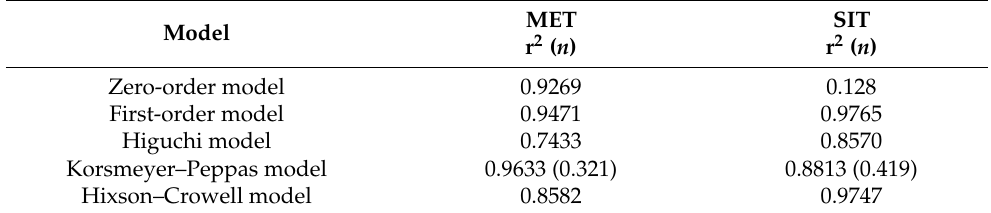
Table 4. In vitro release kinetic analysis of MET and SIT from the optimized formulation (R4).